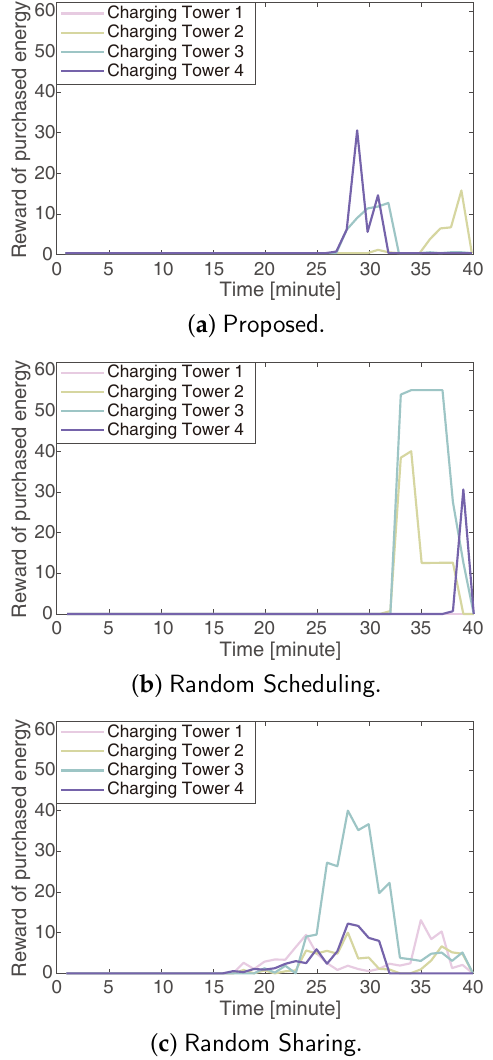
Figure 5. Purchased energy from a local energy market utility company with ( a ) the Proposed algorithm, ( b ) the Random Scheduling algorithm, and ( c ) the Random Sharing algorithm. The surplus energy stands for the energy that overflowed due to unnecessarily energy purchases from the local energy market. As presented in Figure 6a,b, the amounts of surplus energies in the Proposed algorithm and the Random Scheduling algorithm are numerically simulated. The simulation results in terms of surplus energy show that the amount in Figure 6a is smaller than that of Figure 6b because our Proposed algorithm outperforms the other. The amounts of surplus energy in the Proposed algorithm is smaller because the corresponding loads in Figure 4 are